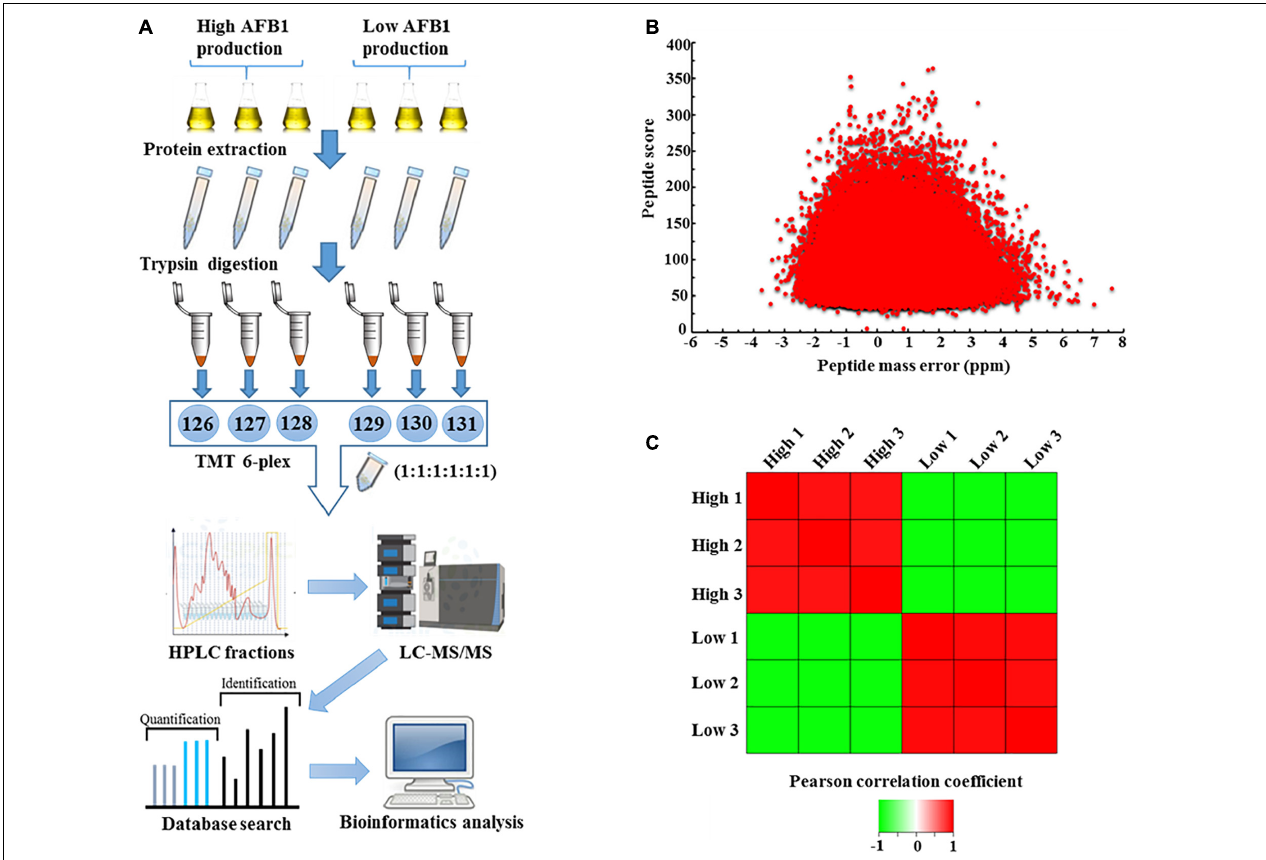
FIGURE 2 | Outline of proteomic quantification in high- and low-aflatoxin-yield A. flavus strains. (A) Workflow for quantification-based proteomic analysis of A. flavus . (B) Distribution of mass error and peptide score of the quantified peptides. (C) Reproducibility analysis of three biological replicates based on Pearson correlation